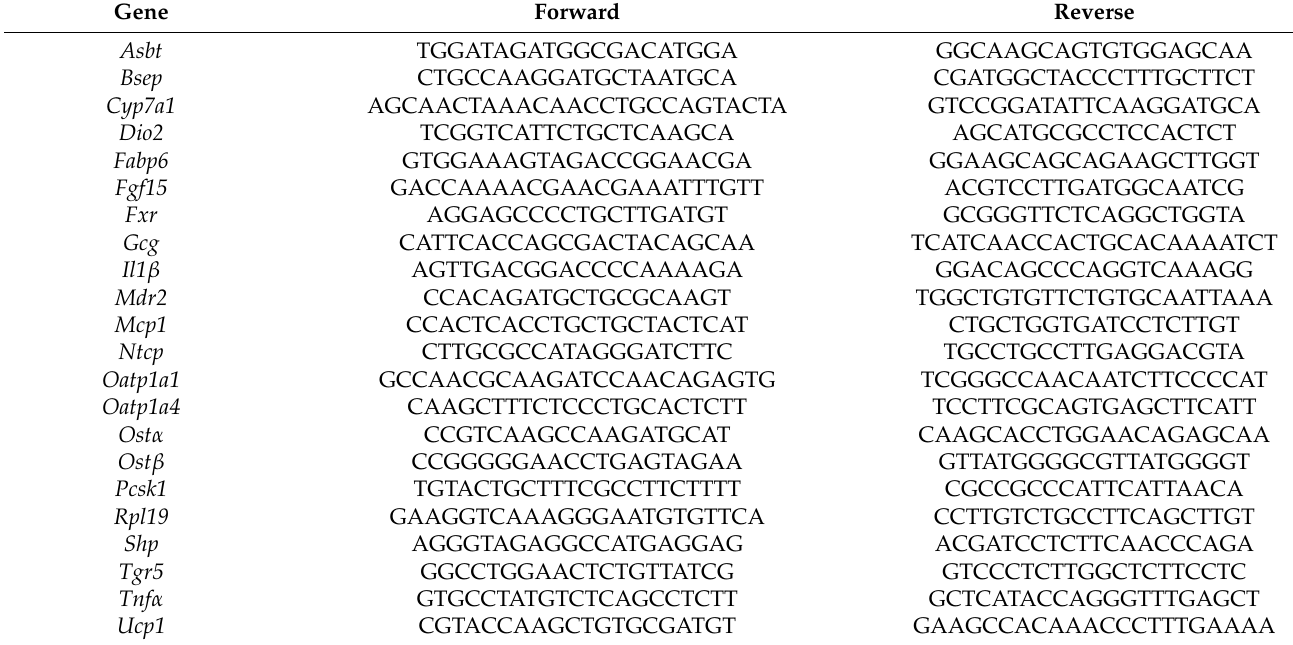
Table 1. Sequences of the primers used for